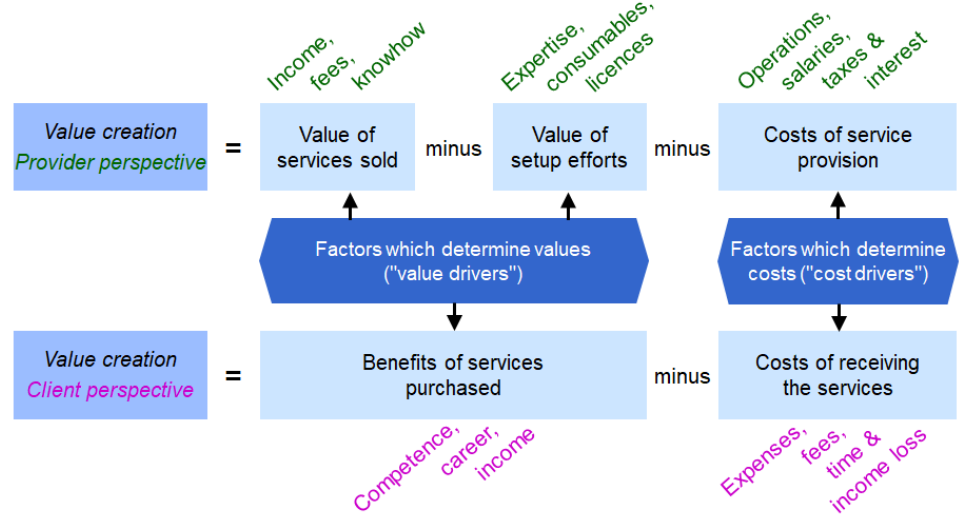
Figure 3. Model of value creation in the education sector (based on Schöni, 2017, p.